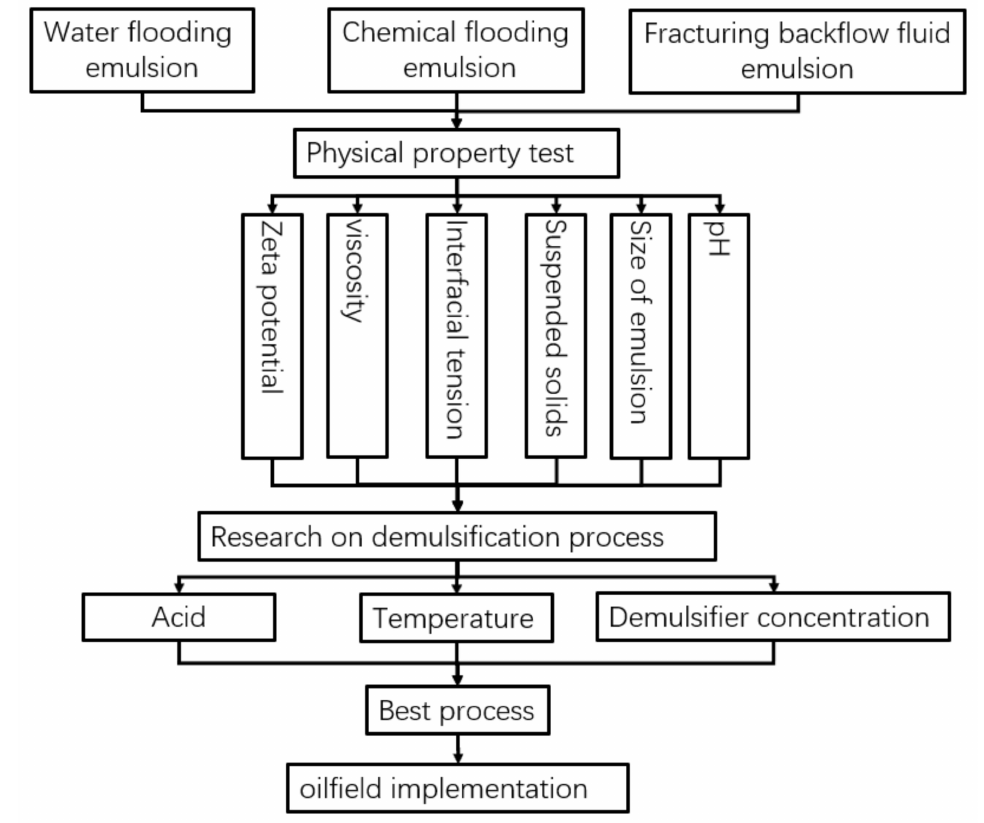
Figure 8. Experimental process of this